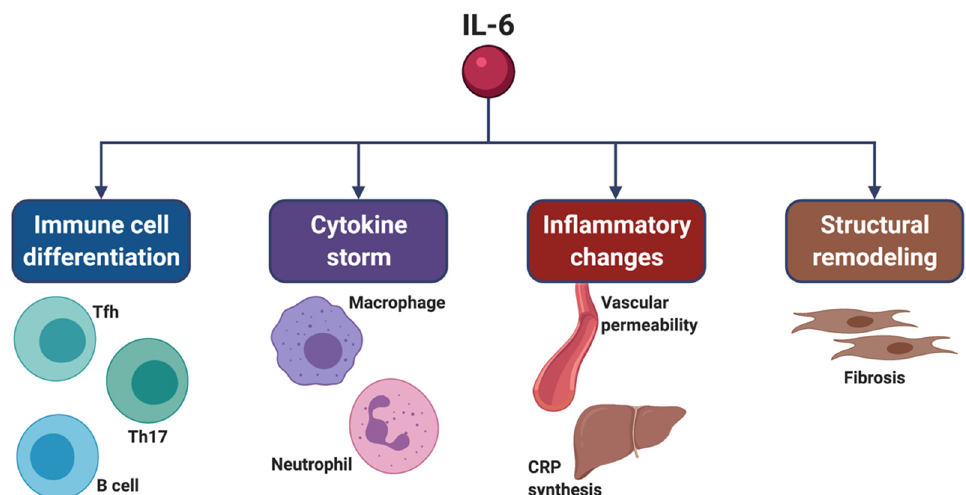
Figure 2. Pleiotropic actions of IL-6, which targets many cell types and tissue districts. IL-6 promotes the differentiation of B cells, as well as of Th17 cells and Tfh cells. By contributing to the differentiation of Th17 cells, IL-6 also induces neutrophil recruitment and macrophage activation, which occur as relevant consequences of cytokine storm. Moreover, IL-6 increases vascular permeability and the hepatic synthesis of CRP, thus significantly contributing to the development and persistence of inflammation. IL-6 also induces tissue remodeling via stimulation of both fibroblast proliferation and production of extracellular matrix proteins. This original figure was created by the authors using BioRender.com. IL-6: interleukin-6; Th17: T helper 17 cell; Tfh: T follicular helper cells; CRP: C-reactive protein.